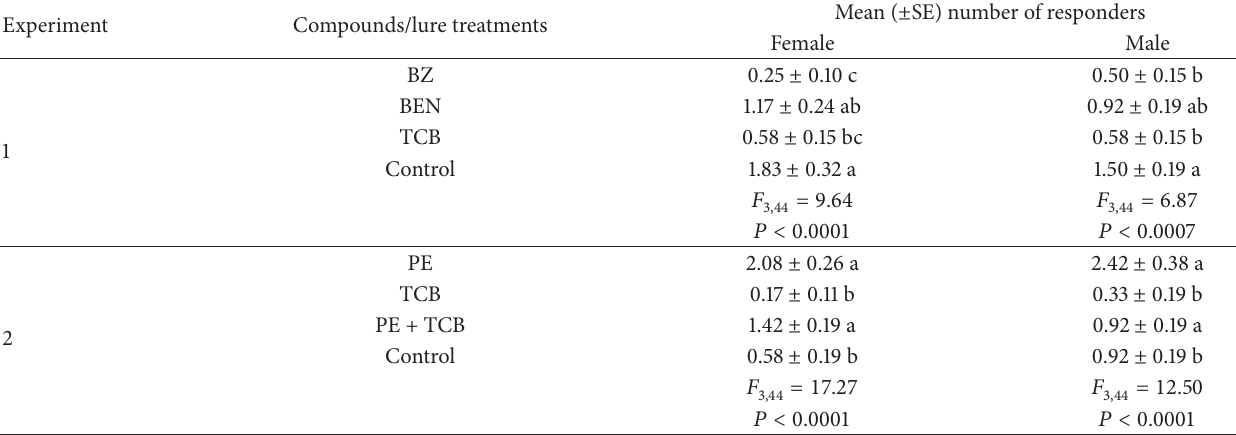
Table 2: Response of C. nenuphar to the tested commercial lures and synthetic pure compounds in four-choice olfactometer bioassays. Experiment